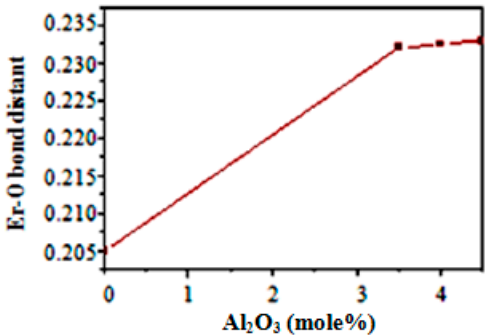
Figure 20. Effect of doping of Al 2 O 3 on variation of Er–O bond distance.